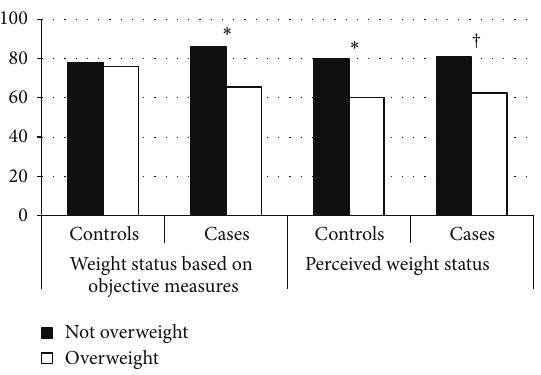
Figure 1: Proportion of children and adolescents with high activity levels who are defined as overweight based on body mass index and based on their parent’s perception of overweight by case- control status. ∗ 𝑃 < 0.05 comparing overweight to not overweight after adjusting for sex, home air filter, maternal smoking during pregnancy, bare bedroom floor in the first year of life, age group, season of testing, tobacco smoke exposure, and high soft drink or fast food consumption. † 𝑃 = 0.11 comparing overweight to not overweight after adjusting for sex, home air filter, maternal smoking during pregnancy, bare bedroom floor in the first year of life, age group, season of testing, tobacco smoke exposure, and high soft drink or fast food